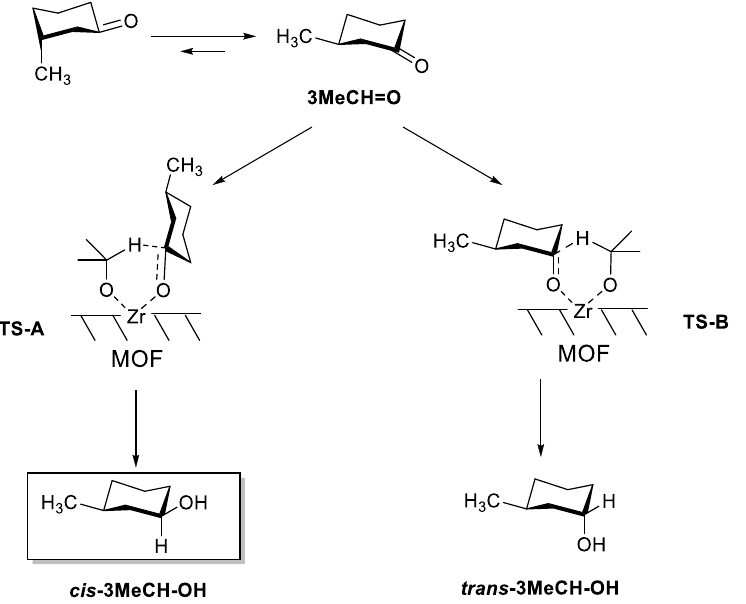
Scheme 2. Conformers of 3MeCH = O, and the two possible transition states leading to cis